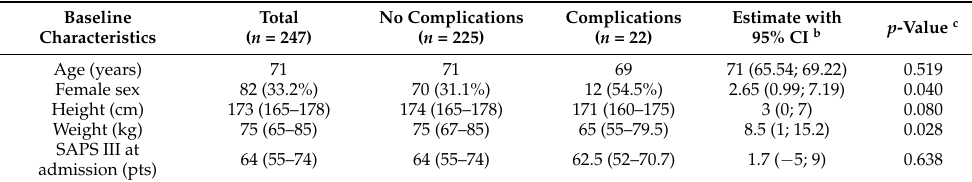
Table 1. Demographics a of patient population ( n = 247).